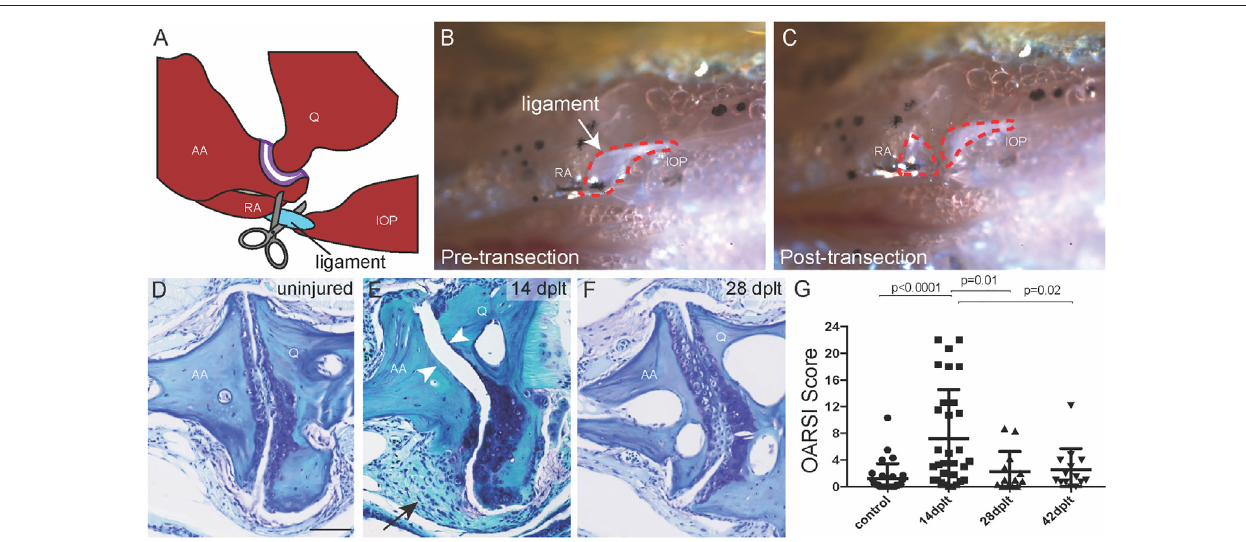
FIGURE1| Joint degenerationand recovery following ligament transectionsurgery. (A) Schematic ofthebones ofthezebra fi sh jaw relative tothejaw joint(purple) and the interopercular – mandibular (IOM) ligament (blue) that is surgically transected. (B,C) Re fl ected light images of the zebra fi sh jaw in ventral view show the IOM ligament(dotted redoutline)before (B) andimmediatelyafter (C) transection. (D – F) Toluidinebluestainingofuninjured adultjawjoint (D) andIOM-transectedjawjointat 14 days post-ligament transection (dplt) (E) and 28 dplt (F) . The arrowheads point to the area of cartilage erosion and the arrow to the synovial hyperplasia. (G) Quanti fi cationofjawjointdegenerationafterIOMtransectionusingthezebra fi shOARSIscoringmethod; n (cid:1) 29uninjured; n (cid:1) 31 at14dplt; n (cid:1) 13 at28dplt; n (cid:1) 14 at42 dplt. Individual data points, mean, and standard error of the mean are shown. The p -values are calculated by ANOVA and Tukey ’ s multiple-comparison test. AA, anguloarticular bone; IOP, interopercular bone; Q, quadrate bone; RA, retroarticular bone. Scale bar (cid:1) 50 μ m.